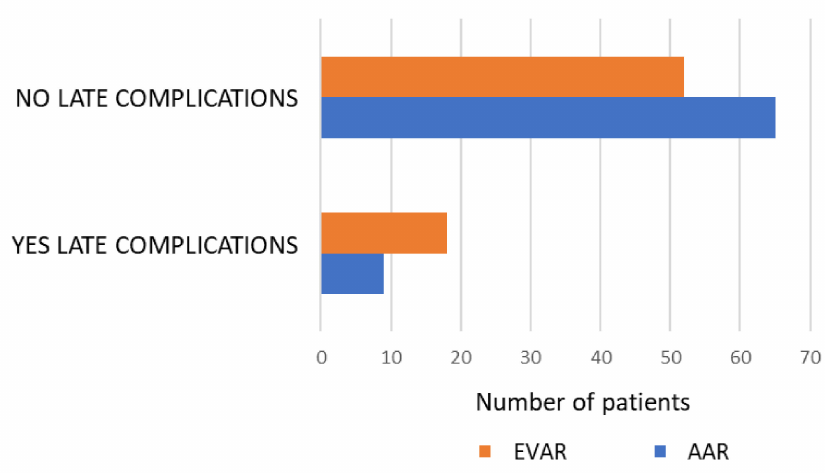
Figure 1. Late complications of AAA due to AAR vs. EVAR. Chi-square comparison: p = 0.013. Table 2. Distribution of the scores of the Spanish version of the SF-36 health questionnaire for the total number of patients operated on for AAA.